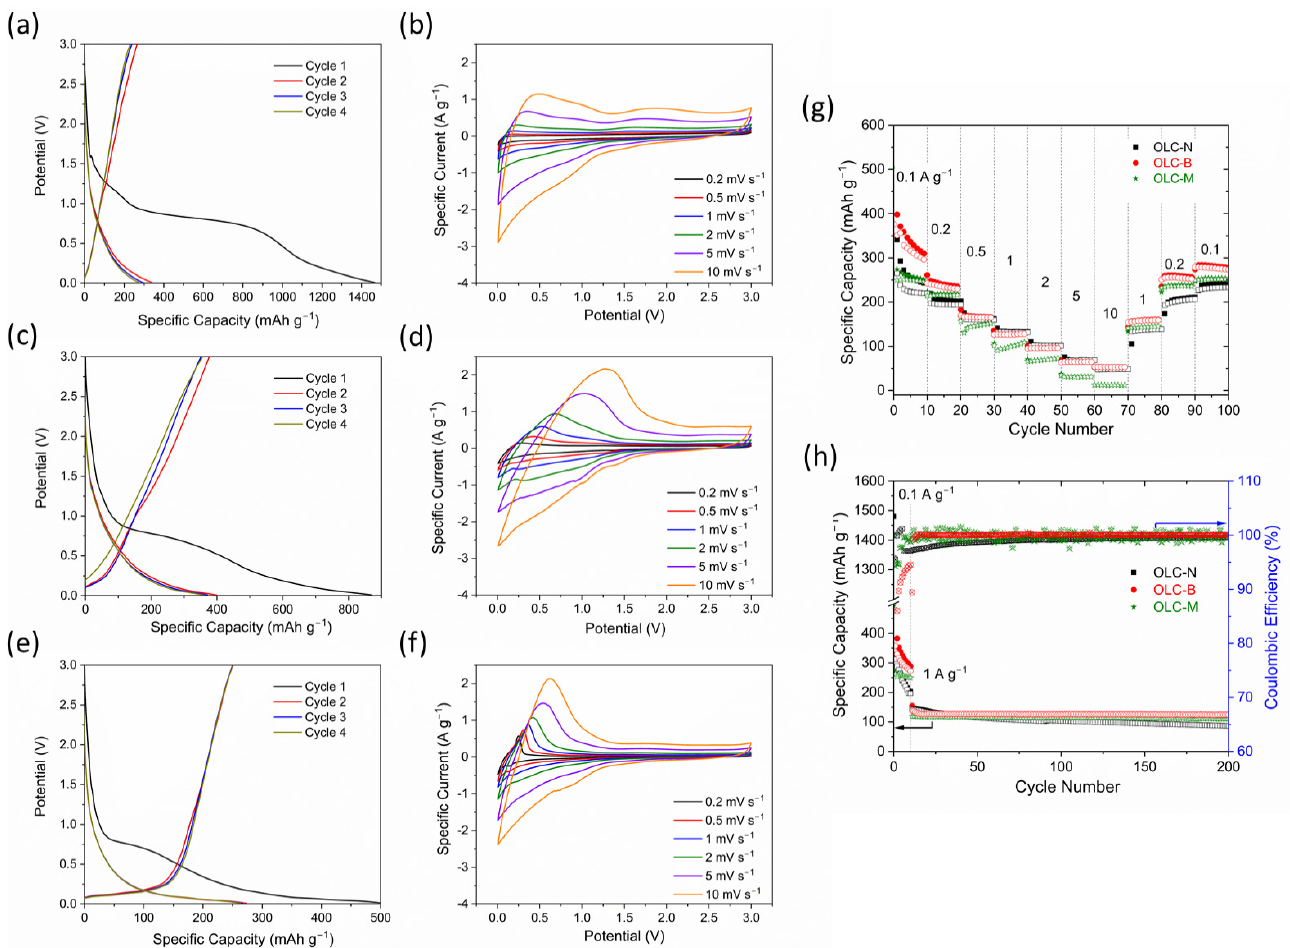
Figure 4. GCPL profile V vs. capacity of initial cycles at 0.1 A g − 1 and CV profiles at various scan rates for ( a , b ) OLC-N, ( c , d ) OLC-B, and ( e , f ) OLC-M, as well as GCPL ( g ) rate performance and ( h ) cycle performance in a LIB half-cell system.